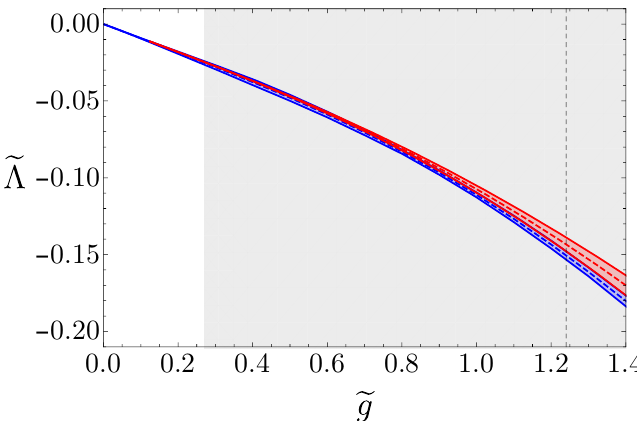
Figure 6 . The vacuum energy (cid:3) at strong coupling obtained by resummation of the EPT series (4.8) with the conformal mapping (light blue) and Pad(cid:19)e-Borel (light red) methods. The region beyond e the phase transition g > g ( w ) c is shaded in gray and the vertical dashed line signals the critical coupling in the strong branch g = g ( s ) c e e e e